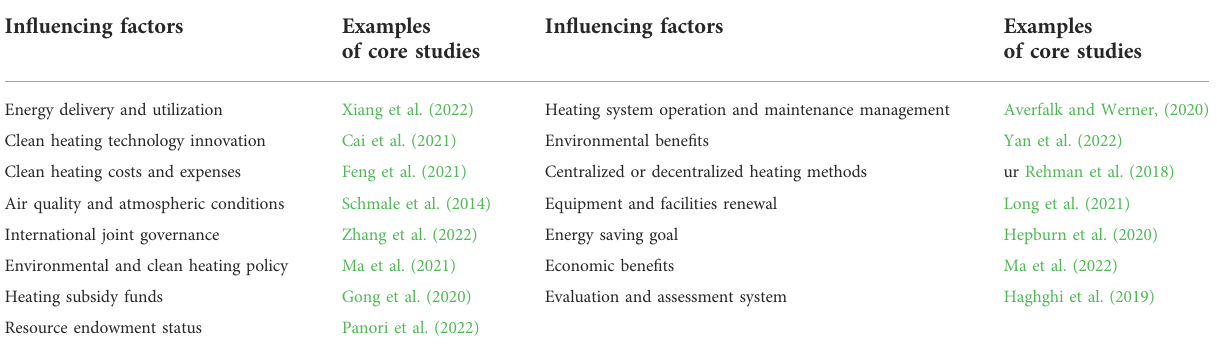
TABLE 2 Examples of core